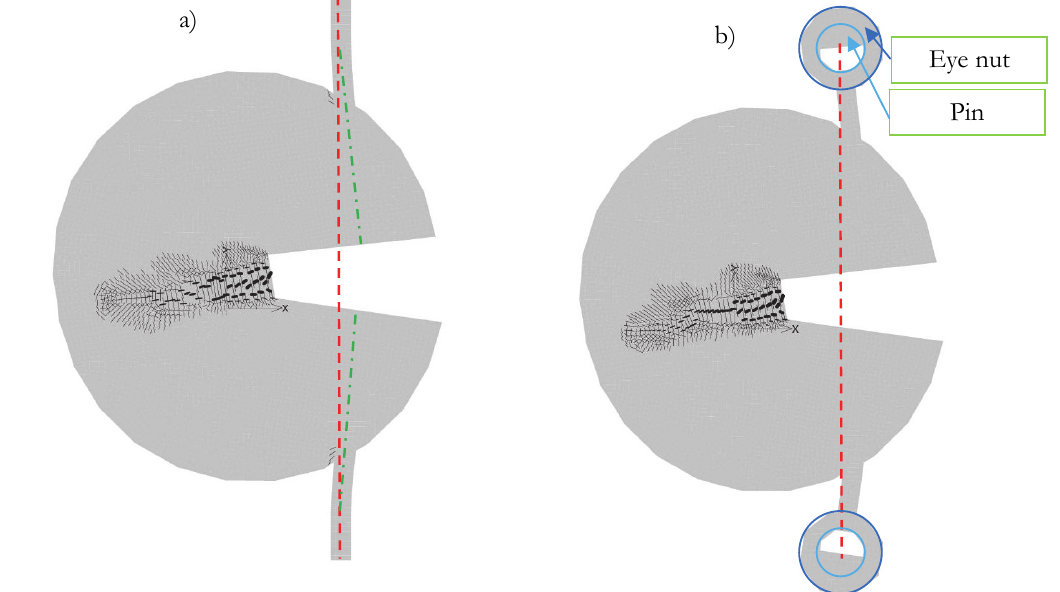
Figure 8: Results of MCT numerical models with cracks – deformed models magnified 200